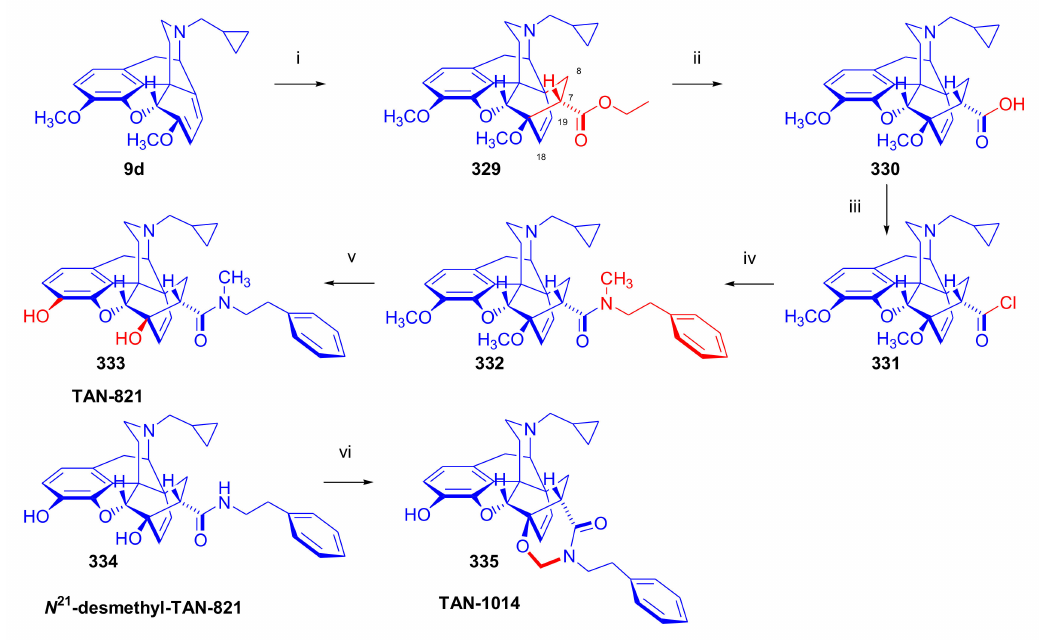
Figure 85. Synthesis of 6,14-ethenomorphinan ligands for the putative ε opioid receptor. Reagents and conditions : (i): ethyl acrylate, reflux, 15 h, 69%; (ii): 6M HCl, reflux, 7 h, 76%; (iii): oxalyl chloride, CHCl 3 , reflux, 2 h; (iv): N -methy- N -phenethylamine, Et 3 N, CHCl 3 , room temperature, 1 h; (v): 1M BBr 3 in CH 2 Cl 2 , CHCl 2 , 0 ◦ C, 1 h, 74%; and (vi): (CH 2 O) n , H 2 SO 4 , dioxane, reflux, 11 h,